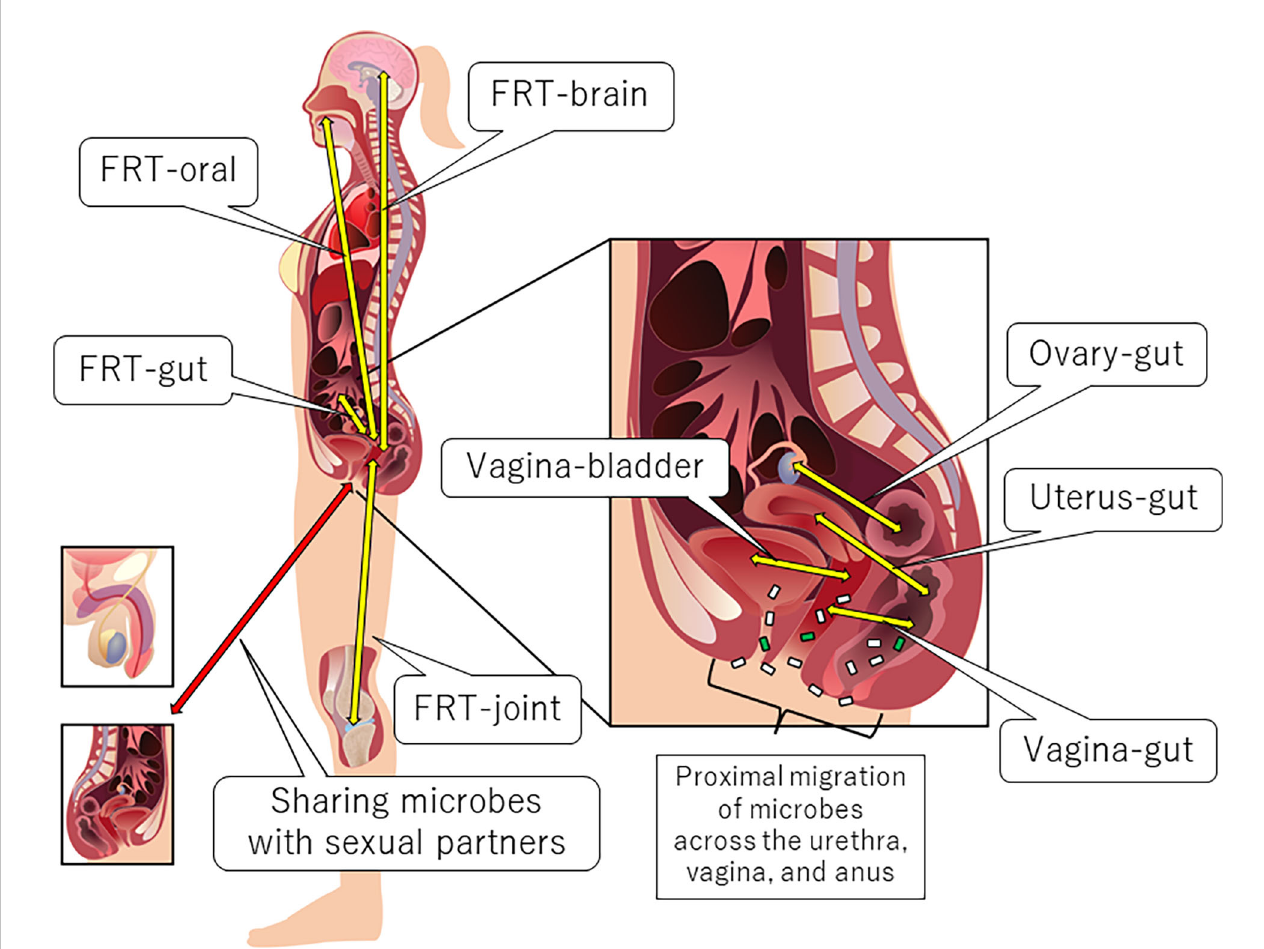
FIGURE 1 Anatomical overview of the FRT-organ axes. Each axis can be characterized by proximal or distal interactions. Traf fi cking of bacterial species is a unique aspect of proximal axes compared to other distal axes. However, distal bacterial translocation might occur systemically via the bloodstream, especially in pathological conditions accompanied by the dysregulation of epithelial barrier